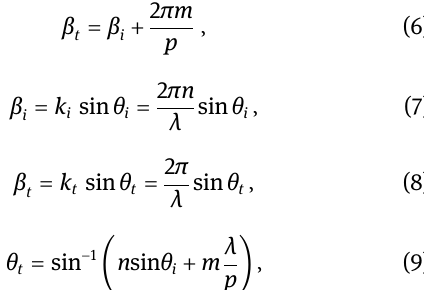
Figure 5: Schematic of diffraction in the vHMM. θ t can be varied despite constant θ i if the diffraction occurs. However, the diffraction isnotvalidinthevHMMbecauseboth p and θ i aresuf fi